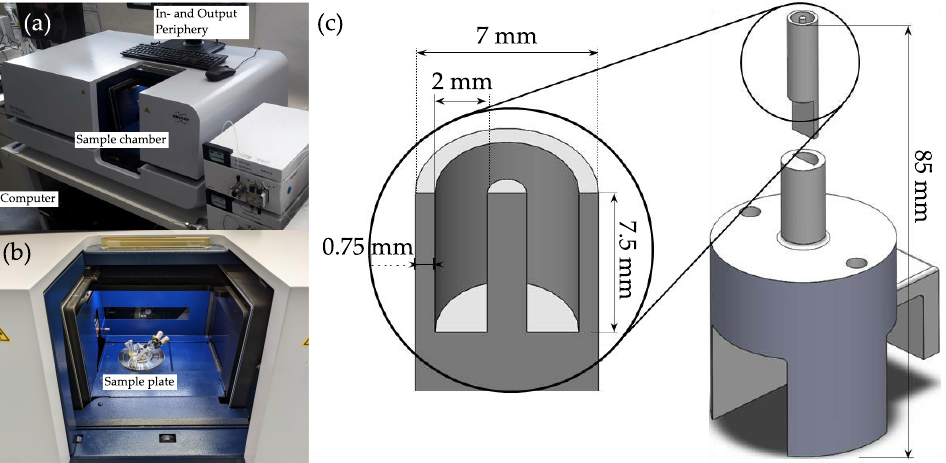
Figure 1. Images of the µCT device ( a ) and the sample chamber ( b ). ( c ) shows the holder for the crystalline sample (top) made from PTFE. The bottom part can be installed to the rotating sample plate and is 3D-printed from PLA.